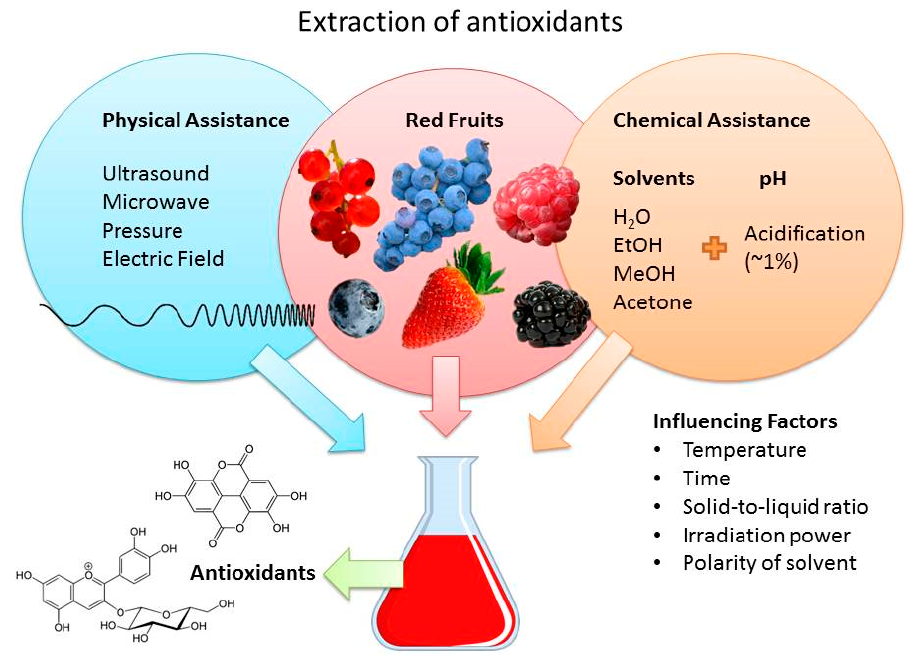
Figure 6. Scheme of the extraction of antioxidants from red fruits.